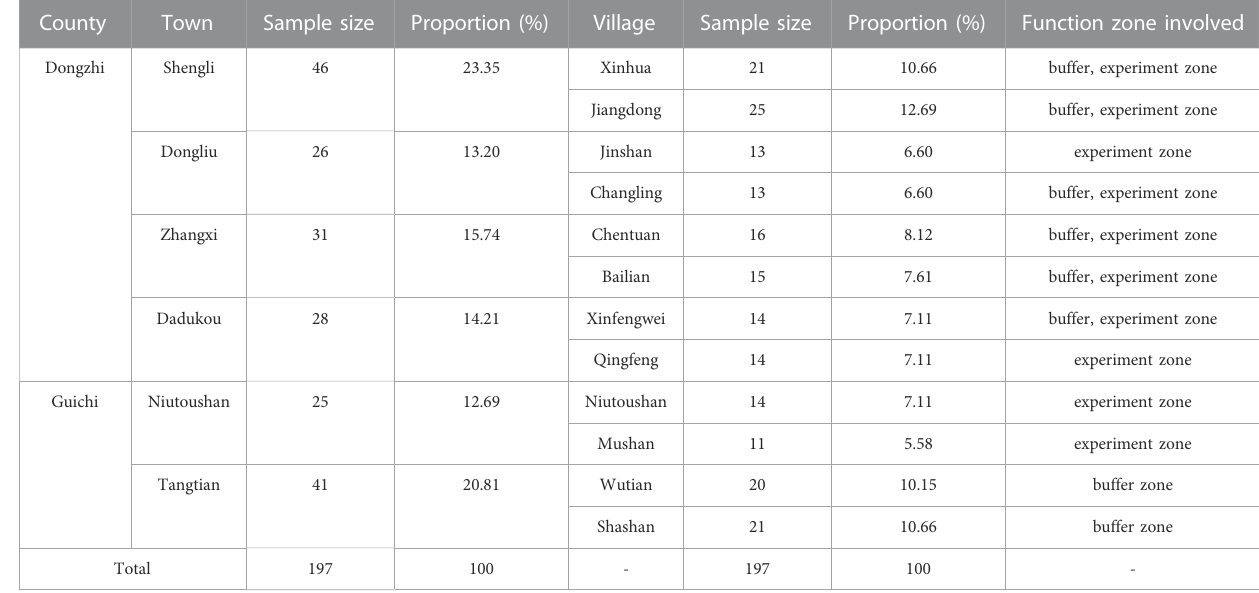
TABLE 1 Distribution of the valid